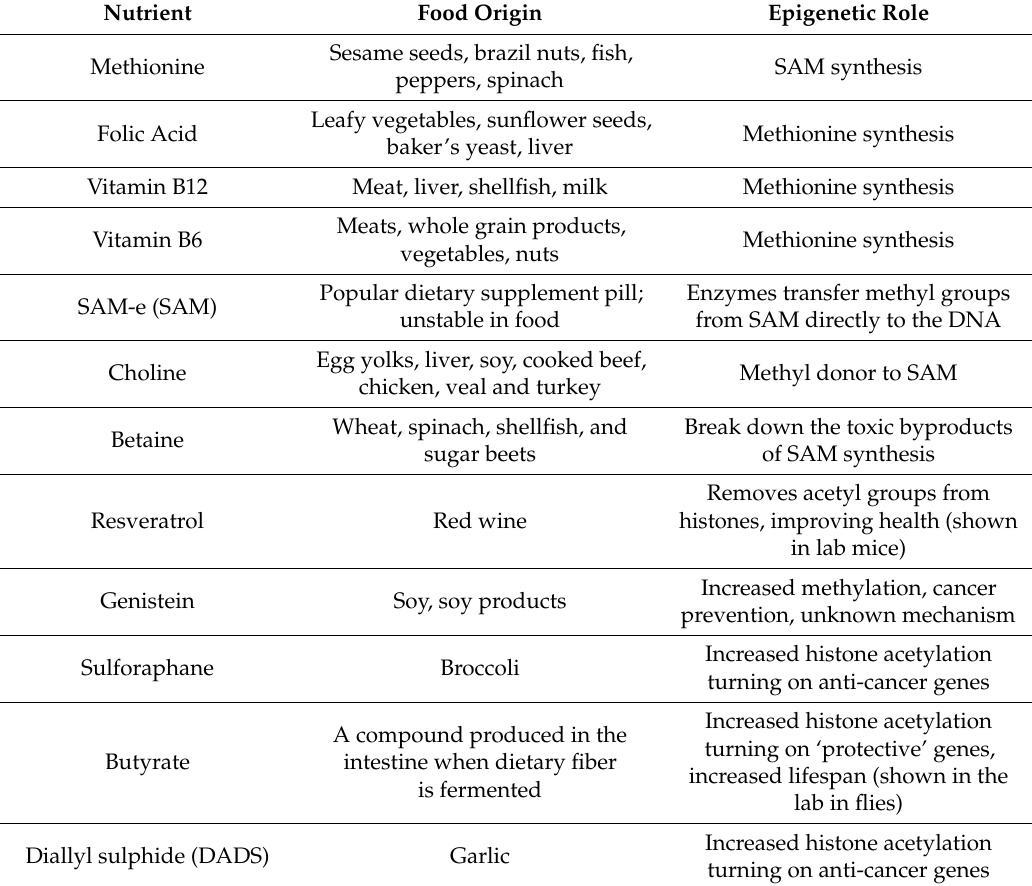
Table 1. A summary of some dietary components considered to have protective effects against